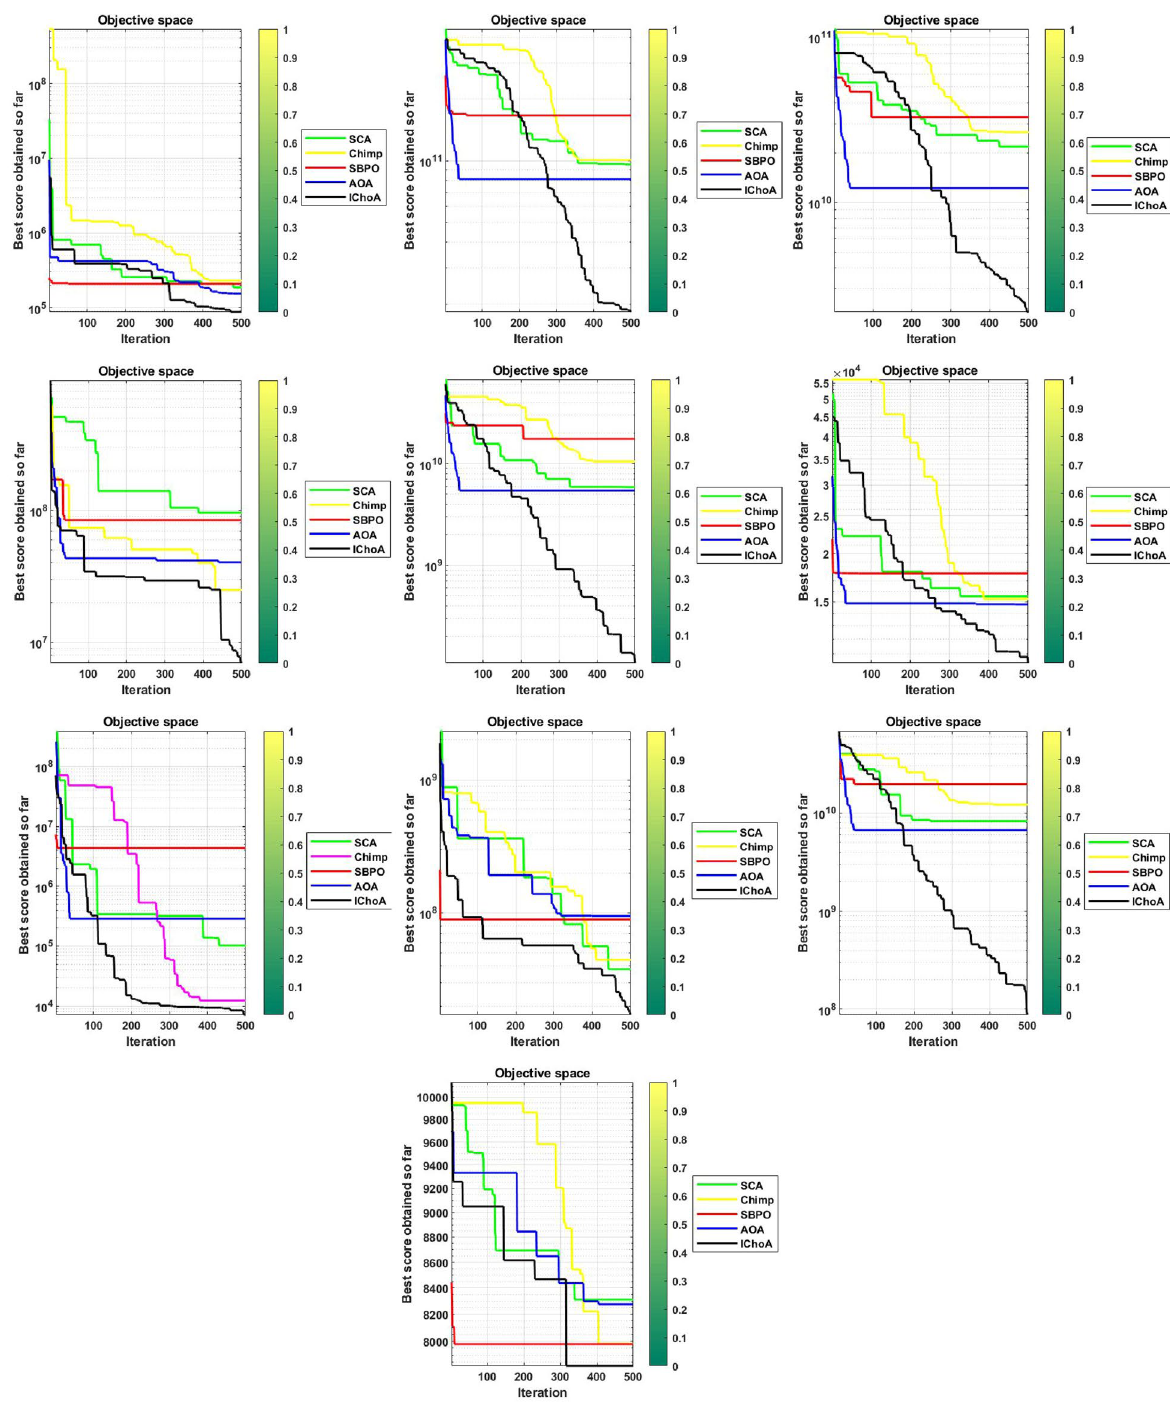
Figure 5. Convergence graphs of evolutionary algorithms on hybrid test